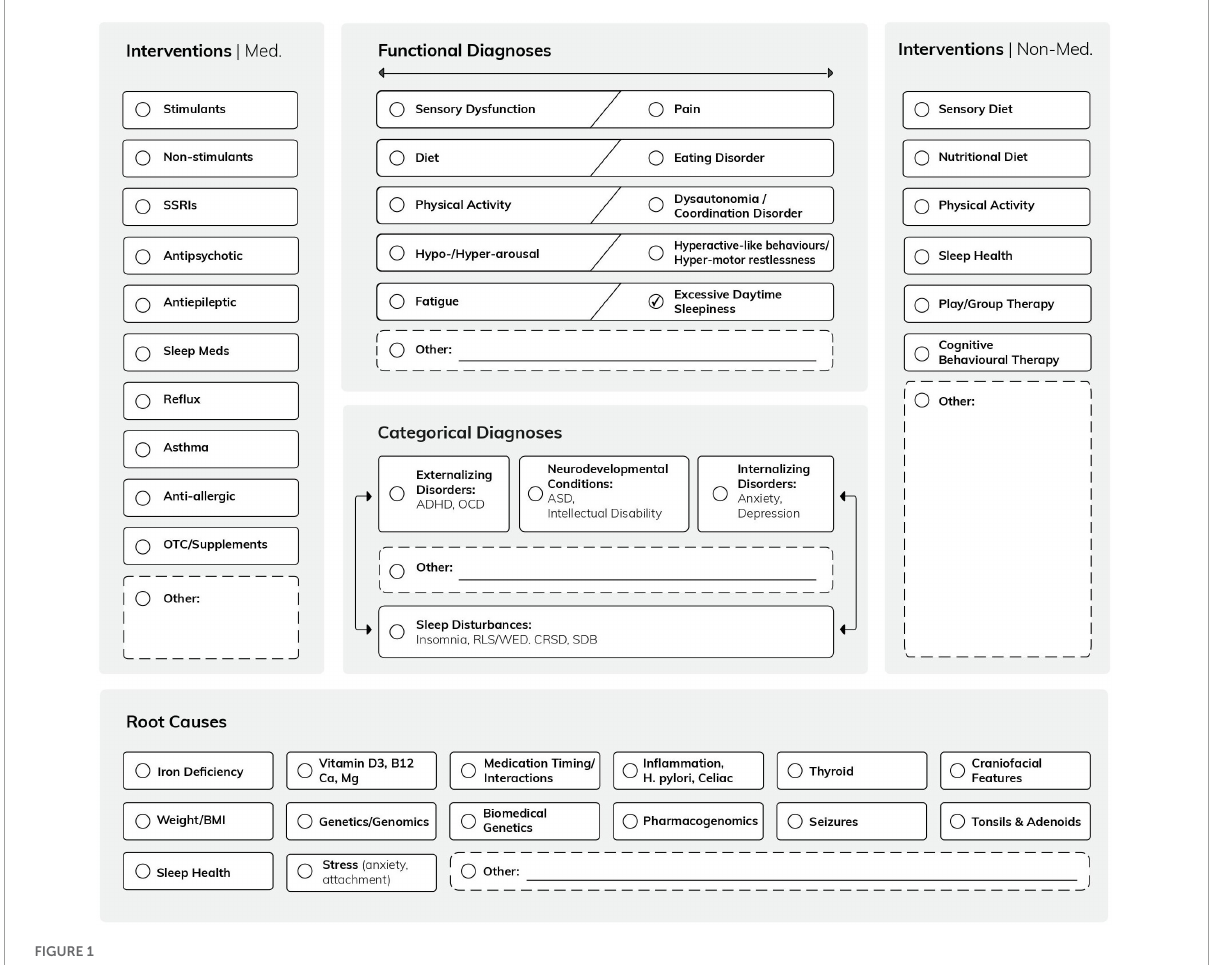
FIGURE1 The Mind-the-Gap logic model shows the interconnections of several contributing factors (“possible root causes”) with functional and categorical diagnoses. This conceptual framework allows the addition of further functional diagnoses, possible causes, and interventions, as it is designed as a grid. (Note that the logic model is a conceptual framework and its applicability is tested in clinical practice)